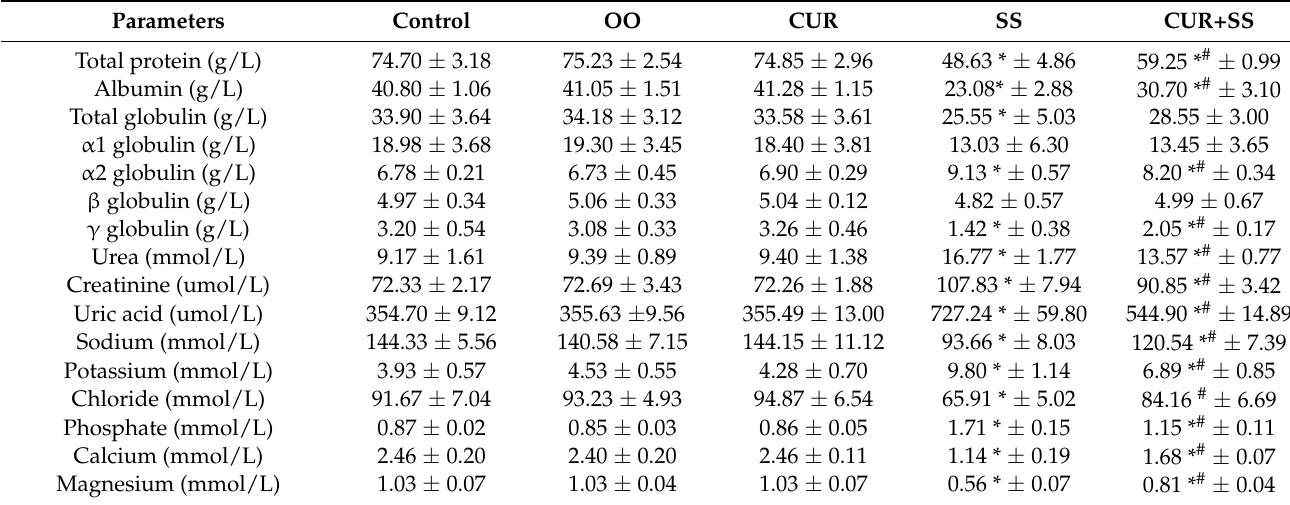
Table 2. Effect of curcumin (CUR) treatment on biochemical indicators of sodium salicylate (SS) administered rats for 15